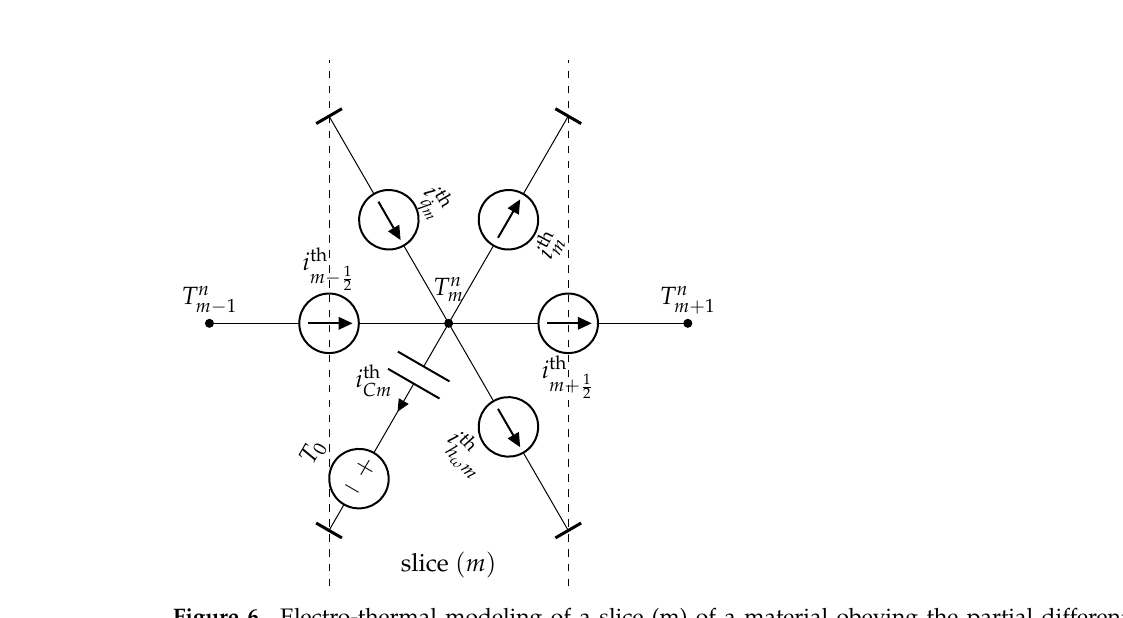
Figure 6. Electro-thermal modeling of a slice (m) of a material obeying the partial differential Equation